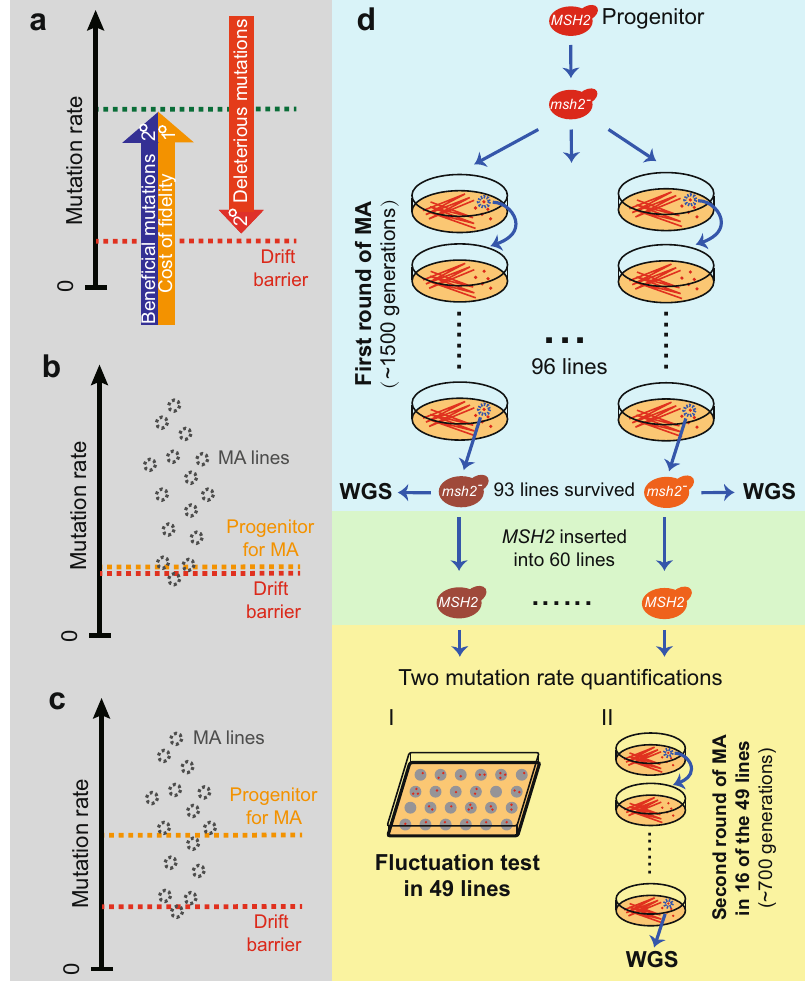
Fig. 1 Theoretical framework of mutation rate evolution and the study design. a Three selective forces (arrows) potentially drive the evolution of the mutation rate μ . 1° and 2° represent fi rst-order and second-order selections, respectively. Bene fi cial mutations and cost of fi delity induce selections for higher μ , while deleterious mutations induce a selection for lower μ . If the selections raising μ are negligible, μ is pushed to the red dotted line that represents the drift barrier; otherwise, μ is at the green dotted line that is well above the drift barrier. Predicted relationships in μ among the drift barrier (red line), progenitor for mutation accumulation (MA) (orange line), and multiple resultant MA lines (gray circles), under the drift barrier hypothesis ( b ) or the conventional model in which a balance between opposing selections maintains μ well above the drift barrier ( c ). d Study design. WGS, whole-genome